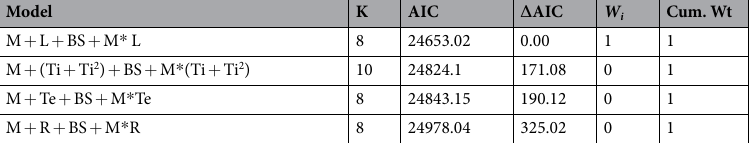
Table 1. Models explaining variation in foraging activity (presence or absence from the core nesting area (10% kernel estimate)). Model selection based on Akaike Information Criterion scores (AIC). Results show the top ranked model included light level (measured as solar radiation (W/m 2 )) and held 100% of the weight. The analysis revealed that light level and its interaction with morph was the better explanatory variable when compared with either temperature, rainfall or time of day. AICc weight ( W i ). Rain = average hourly rainfall, Temperature = average hourly temperature and Time = time (and its quadratic term). K denotes the number of parameters (K), change in AIC relative to the highest ranked model ( Δ AIC), AIC weight ( W i ). Morph = M, Light = L, Breeding stage = BS, Time = Ti, Temperature = Te, Rain =